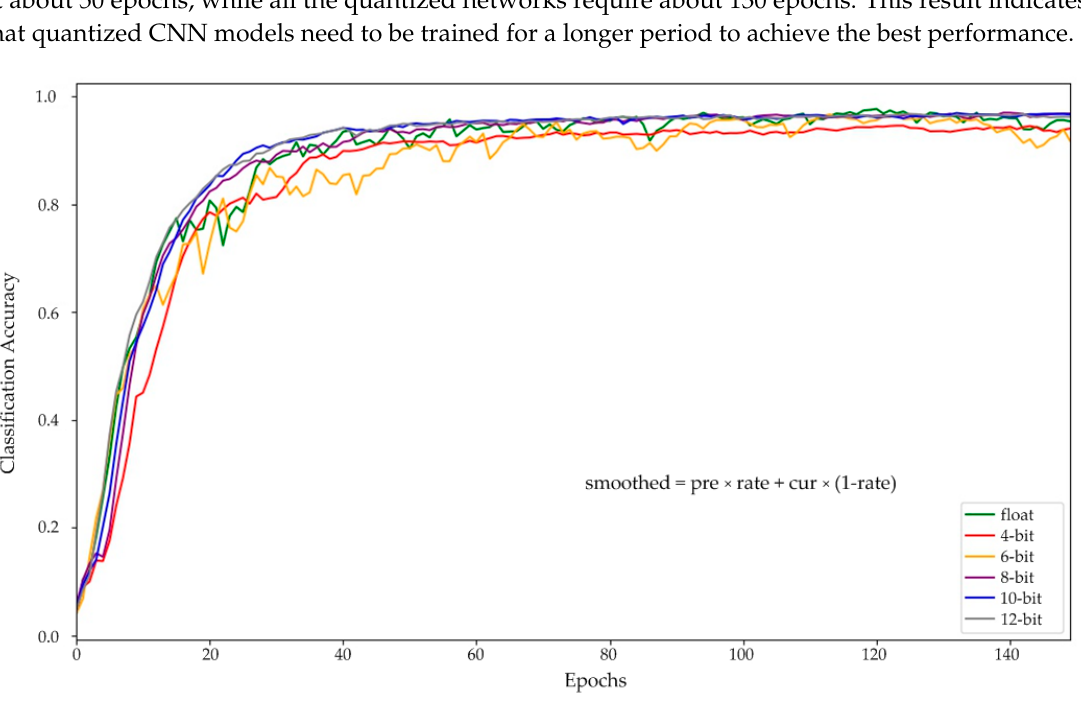
Figure 9. Training processes of the fundamental floating-point-type and quantized-type networks.